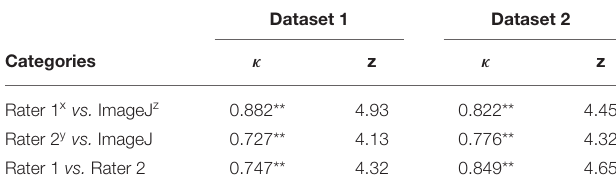
TABLE 3 | Values of weighted Kappa ( κ ) analysis for inter-rater agreement between raters and ImageJ in Dataset 1 (maturing and non-matured spikes) and Dataset 2 (non-matured spikes) of wheat spike blast under controlled